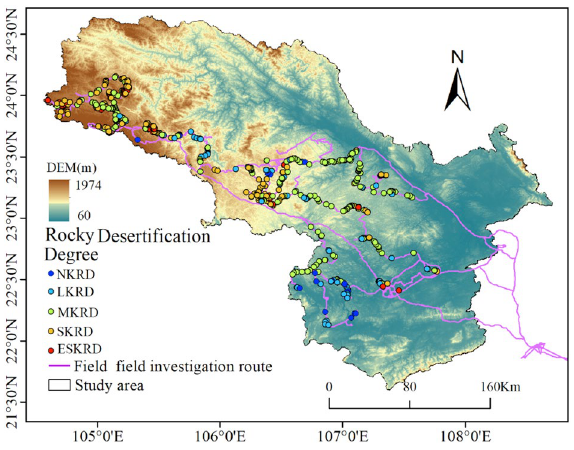
Figure 7. Field data survey map of karst rocky desertification. Map was generated using QGIS 3.26.2 (https:// www. qgis. org/ en/ site/).